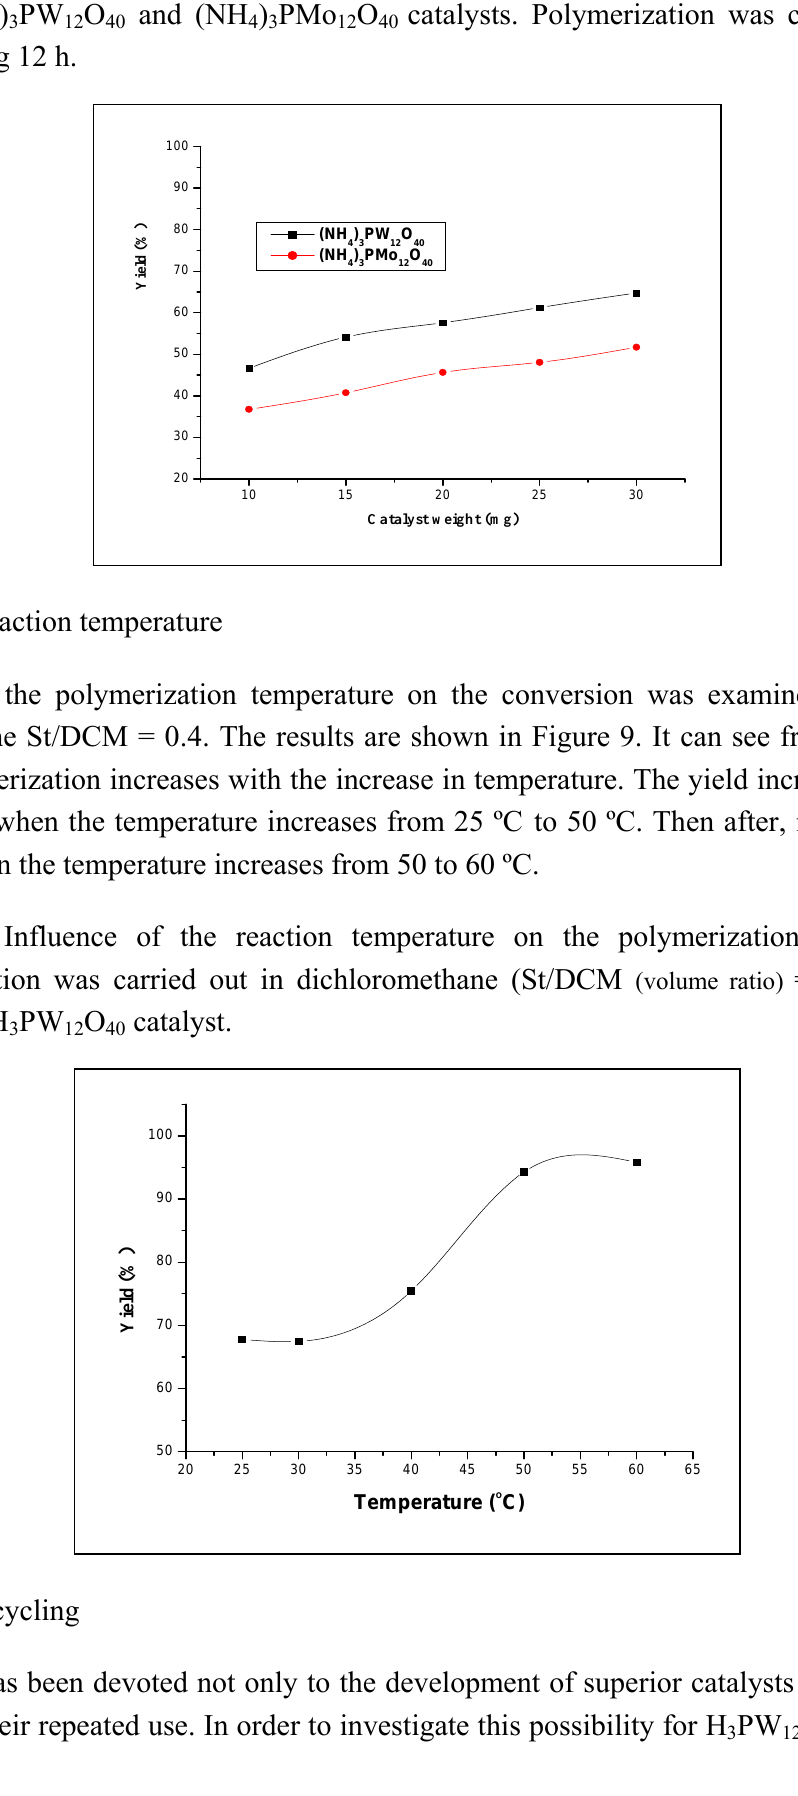
) PW O and (NH ) PMo O catalysts. Polymerization was carried out at 4 3 12 40 4 3 12 40